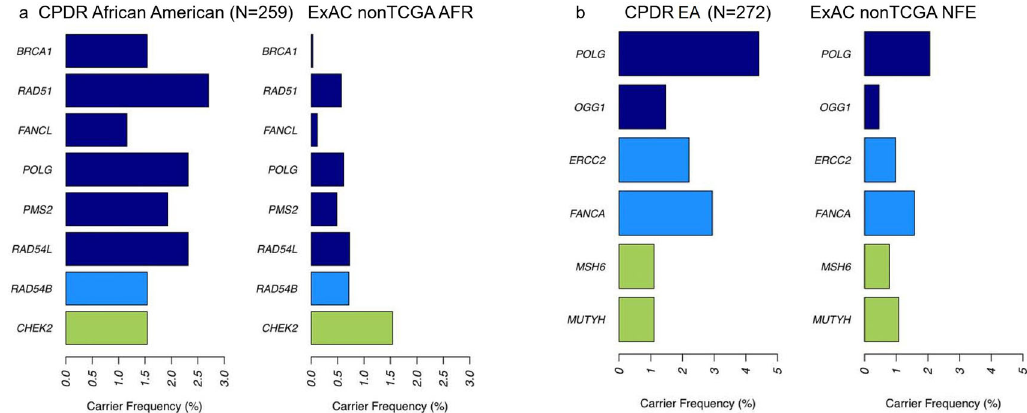
Fig. 3 Gene Based Total Frequency of DDRG Germline Mutations Compared to Relevant Control Database. Gene based total frequency tests were performed using germline mutants on DDR genes. Two-sided Fisher ’ s exact tests were conducted using two by two table of number of carriers and non- carriers in this cohort and corresponding cohort in ExACnonTCGA. DDR genes with at least three carriers in CPDR AA or European Ancestry (EA) cohort are tested, ( a ) Bar plot of total frequency test results by comparing AA cohort and ExACnonTCGA AFR ( b ) Bar plot of total frequency test results by comparing cohort of EA men and ExACnonTCGA NFE. Colors of the bars indicate Fisher Exact Test P values of case vs. control comparison. Dark blue: P < 0.05; Light blue: 0.05 < P < 0.1; Green: P > 0.1. Source data are provided as a Source Data fi le.